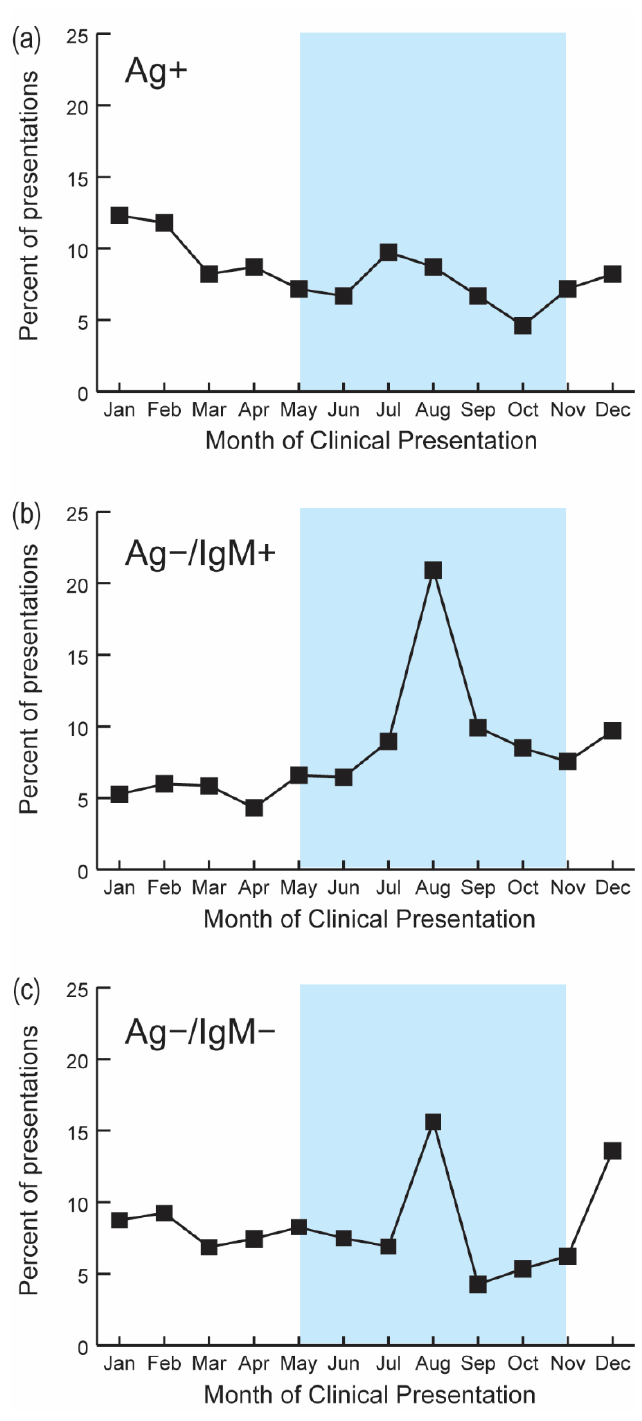
Figure 5. Monthly distribution of suspected LF cases by serostatus. Month of clinical presentation was determined according to the date the initial ELISA Ag and IgM tests were performed. ( a ) Acute Lassa fever exposure (Ag+), ( b ) Recent Lassa fever exposure (Ag−/IgM+); ( c ) Non-Lassa fever cases or prior Lassa fever exposure (Ag−/IgM−) . All tests were for suspected LF cases defined according to its suspected case definition. The blue-shaded regions represent the seasonal rainfall period in Sierra Leone (May to October).